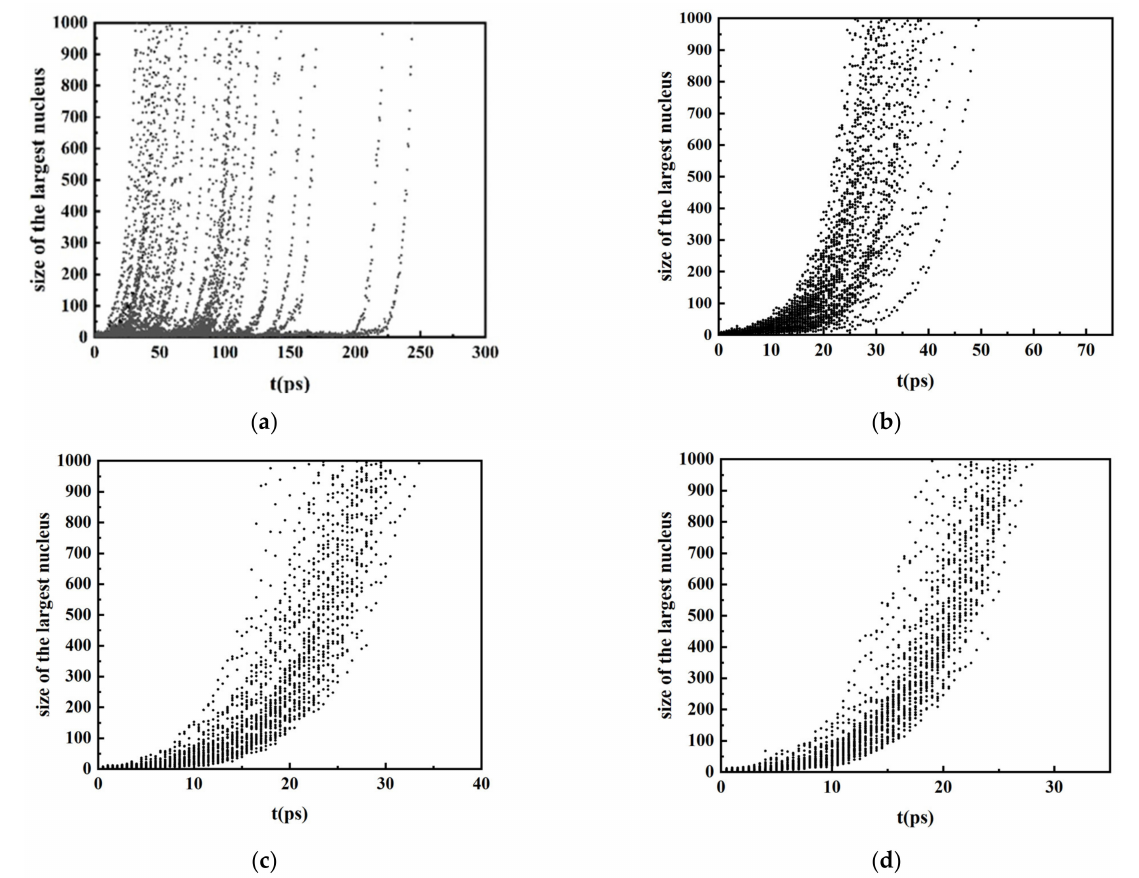
Figure 7. Time dependence of the number of atoms in the largest cluster during the isothermal- solidification process at ( a ) 0 MPa, ( b ) 100 MPa, ( c ) 200 MPa, and ( d ) 300 MPa, respectively. Figure 8 shows the MFPT curves of the largest cluster during the isothermal-solidification process with different pressures, the X axis is the number of atoms in the largest cluster, and the Y axis is the average time. The black points are the average time for the largest cluster to appear in the 50 simulations, and the blue curve denotes MFPT curve fitted with Equation (2).